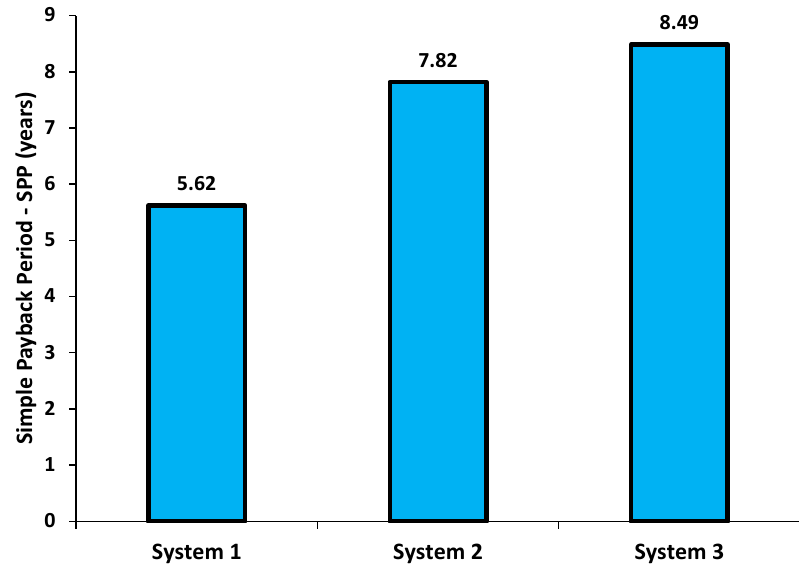
Figure 11. Exergy efficiency of the examined systems.